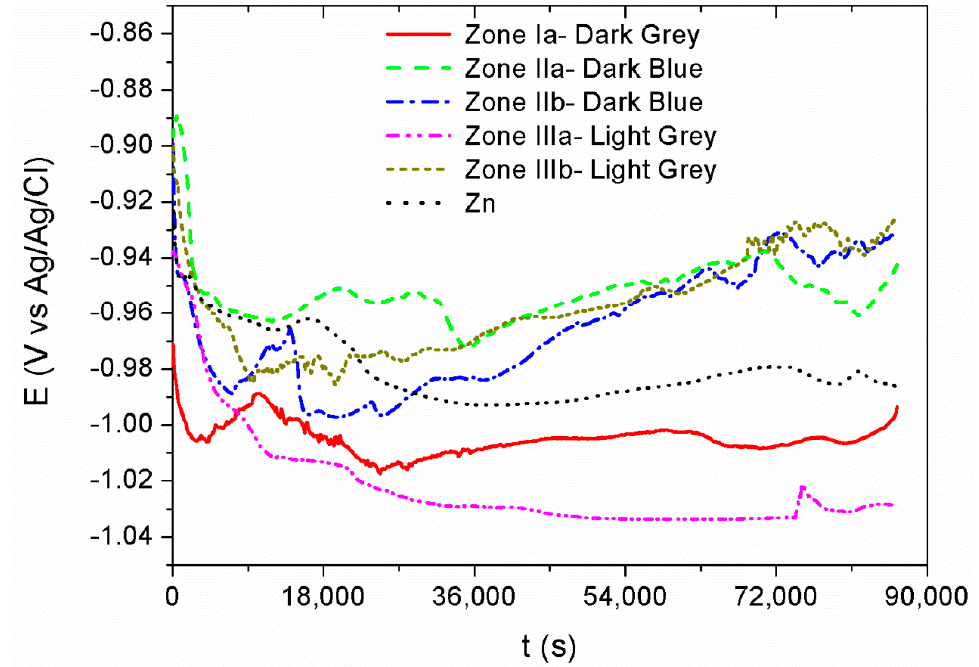
Figure 7. Open circuit potential (OCP) measurements recorded for 24 h for each of the differentiated areas—dark gray, dark blue, and light gray.